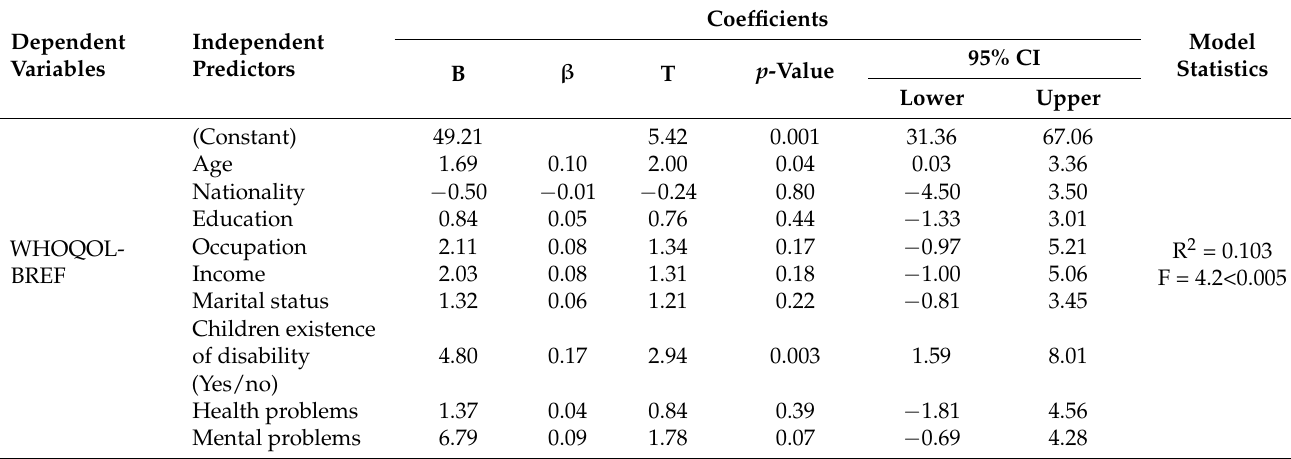
Table 4. Multiple linear regression analysis of WHOQOL-BREF among respondent mothers during the COVID- 19 lockdown ( n = 340).